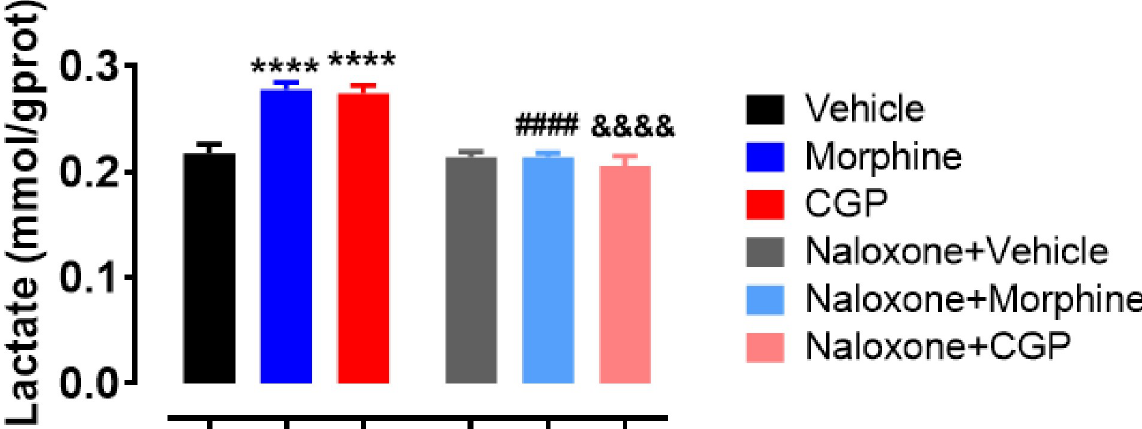
Fig 3. Lactate levels in submandibular gland of Swiss mice after acute treatment with vehicle, morphine or CGP in the presence or absence of naloxone. Morphine and CGP increased lactate levels in submandibular gland, but naloxone restored this parameter to the baseline. CGP, Cyclo-Gly-Pro. Results are represented as mean ± SEM of 6 animals; � P < 0.05 vs. vehicle. One-way ANOVA, Dunnett as post hoc